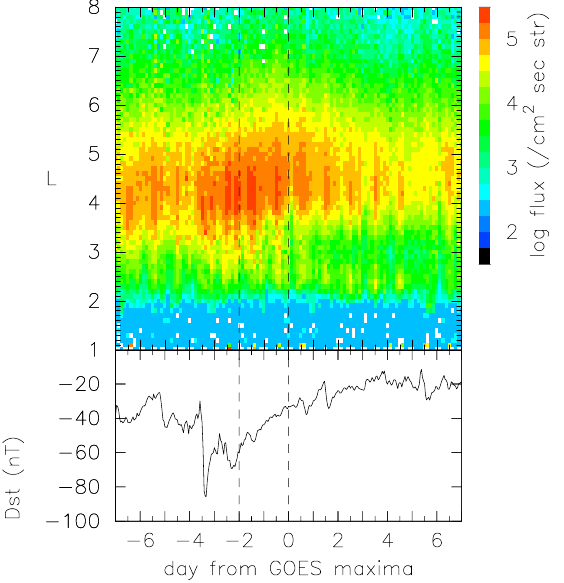
Fig. 3. Average L -t diagram of NOAA-15 300–2500keV electron flux during extreme events superposed at 17:00UT of the day of maximum flux enhancement. The L -value is McIlwain’s L de- rived from the IGRF. The D st index is also shown in the bottom panel. In order to avoid any contamination from the energetic pro- tons, the electron data are not used when the electron flux of the NOAA/MEPED 300–2500keV sensor is less than ten times of the ion flux of the NOAA/MEPED 240–800keV